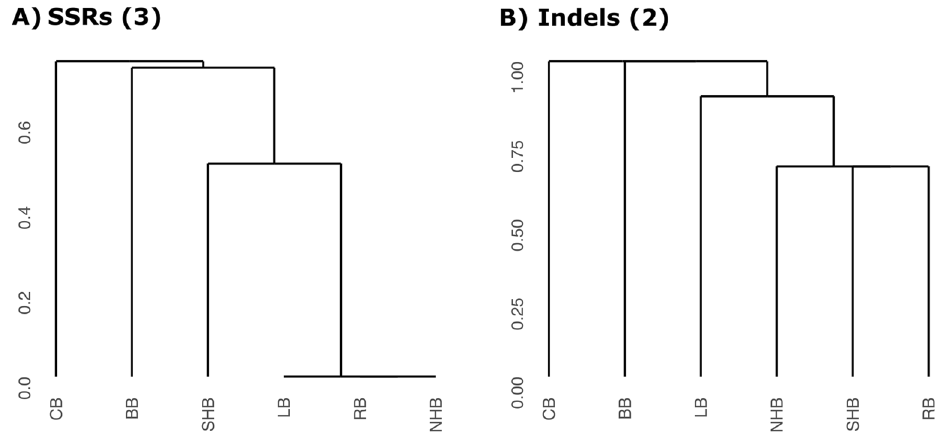
Figure 3. Hierarchical clustering of six economically relevant Vaccinium species using different marker types. ( A ) Dendrogram constructed using three simple sequence repeat markers (SSR3, SSR4, and SSR5). ( B ) Dendrogram constructed using two indel-containing regions (“ rpl36 - rps8” and “ rpoB - rpoA (3)”). SHB: southern highbush blueberry, NHB: northern highbush blueberry, RB: rabbiteye blueberry, LB: lowbush blueberry, BB: bilberry, CB: